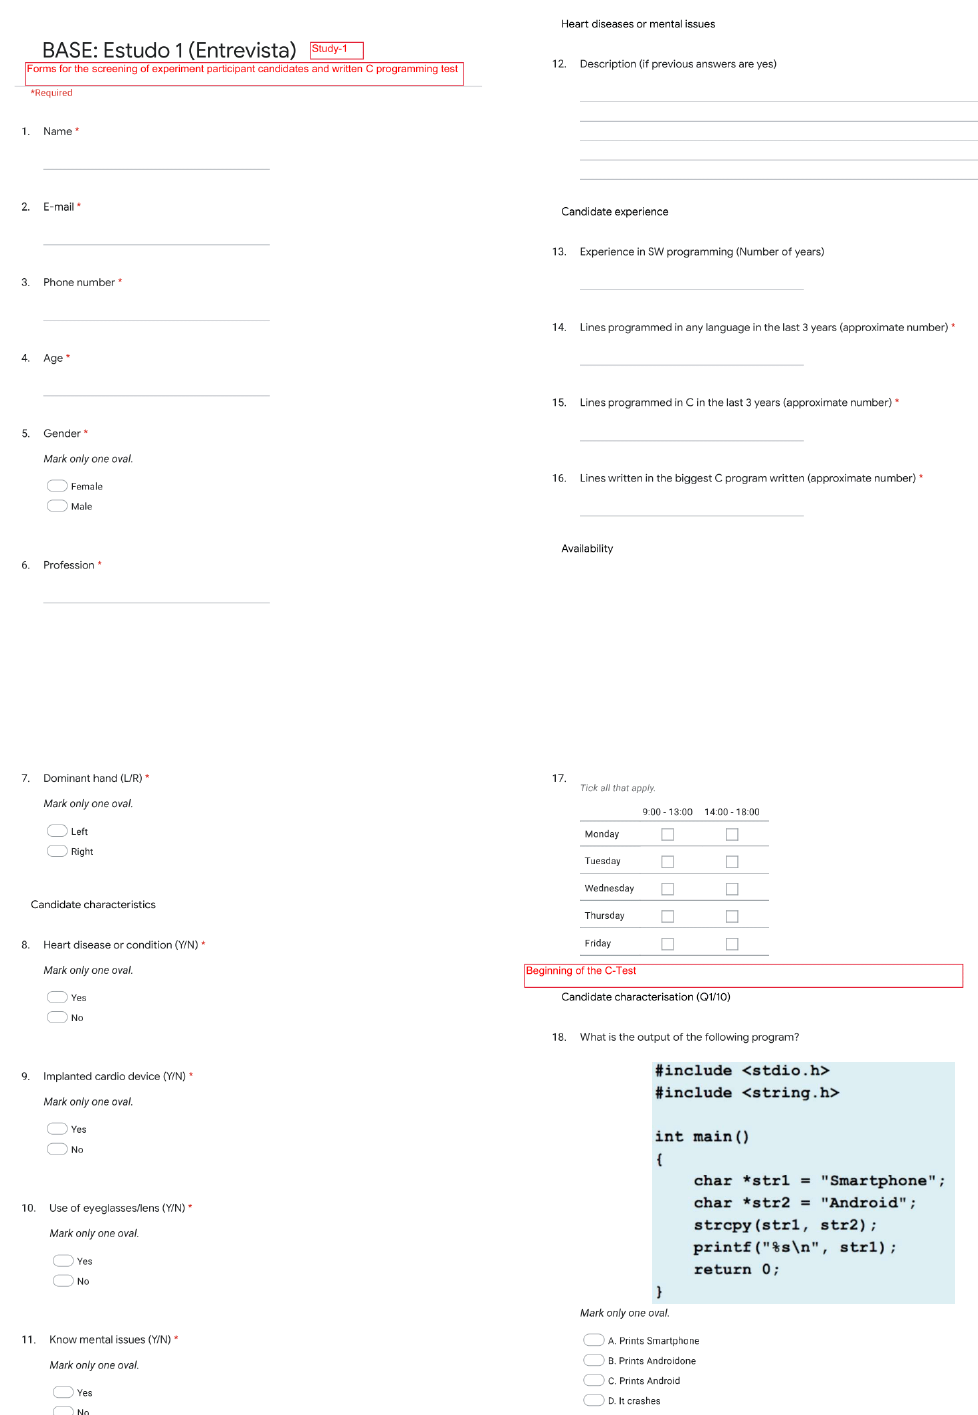
Figure A1. Programming experience questionnaire (questions 1 to 17) and technical questionnaire subpart (question 18).